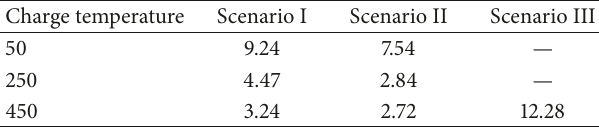
Table 5: Normalized optimal values (US$/t) due to the charge temperature ( ∘ C) considering scenarios I, II, and III.